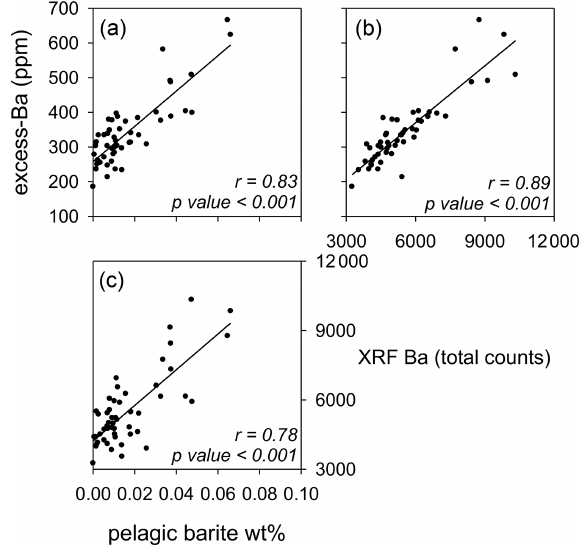
Figure 4. Pelagic marine barite weight percent (wt%), (a, b) excess Ba (ppm), and (c) XRF Ba (total counts) compared to each other. All correlations between barite-related proxies are significant ( p < 0 .